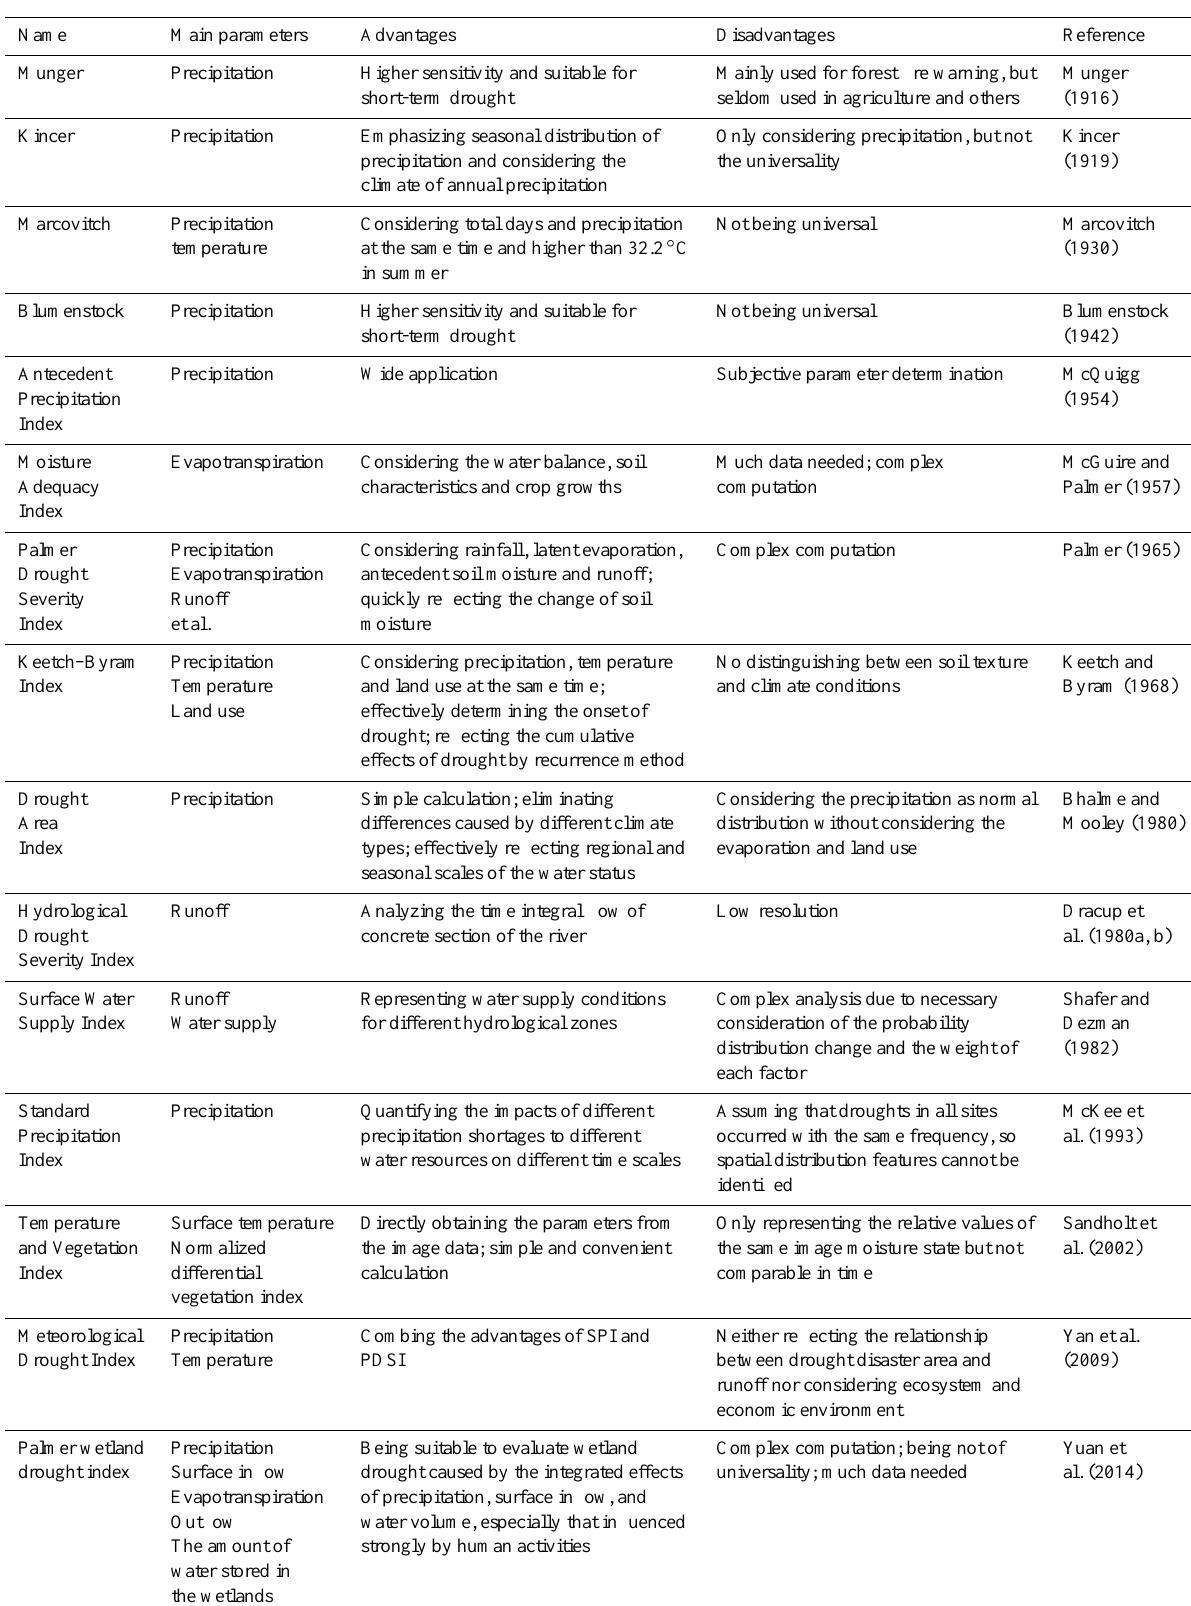
Table 1. Advantages and disadvantages of the common drought